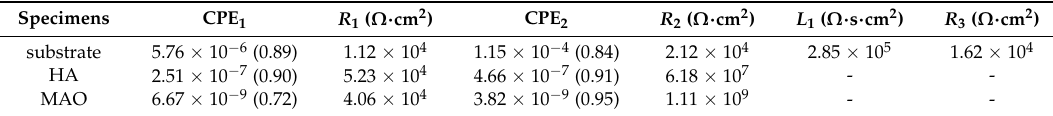
Table 3. Electrochemical impedance spectroscopy (EIS) fitting results for specimens in 3.5 wt % NaCl solution.